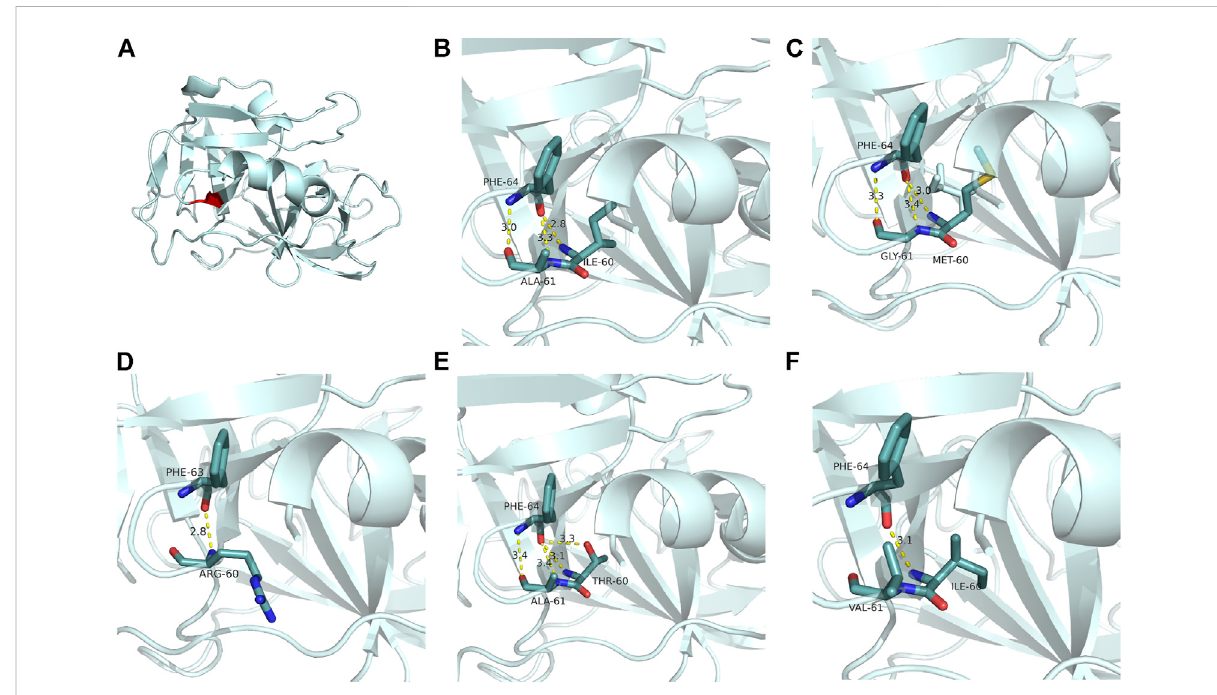
FIGURE 4 Ribbon diagrams of neutrophil elastase. (A) Position (red) of residues Ile60 and Ala61. (B) H-bonds between residues Ile60 and Ala61 and their substratePhe64. (C) ChangedH-bondsinNEmutantI60M,A61G(thepresentcase).Whilethree H-bondsremainedbetweenresidues60and61and Phe64, the bond lengths increased, indicating weakened connections. (D) Phe64 lost two H-bonds with Arg60. (SCN, with a synchronous mutation of GFI1). (E) Phe64 obtained an additional H-bond with Thr60 (SCN). (F) Phe64 lost two H-bonds with Val60 (overlapping between SCN and CyN). Partial tertiary structures were deleted to show the variants and adjacent residues in the ribbon diagrams. The color codes for the molecules and bonds are as follows: carbon, pale cyan; oxygen, red; nitrogen, blue; sulfur, yellow; H-bond, yellow. PD, probing